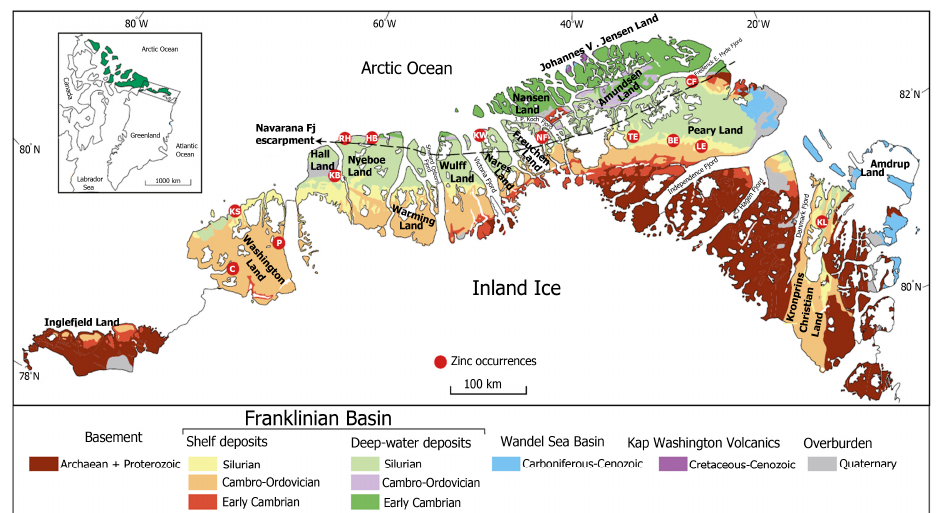
Figure 2. Simplified geological map of the Greenlandic part of the Franklinian Basin showing the distribution of known Zn–Pb occurrences. Inset: location of the Franklinian Basin within the wider context of Greenland and Arctic Canada. Abbreviations to zinc occurrences: BE = Børglum Elv; CF = Citronen Fj; C = Cass Fj; HB = Hand Bugt; KB = Kayser Bjerg; KL = Kronprins Christian Land; KS = Kap Schuchert; KW = Kap Wohlgemuth; LE = Løgum Elv; NF = Navarana Fj; P = Petermann; RH = Repulse Havn; TE = Tvillum Elv (modified from [3]).